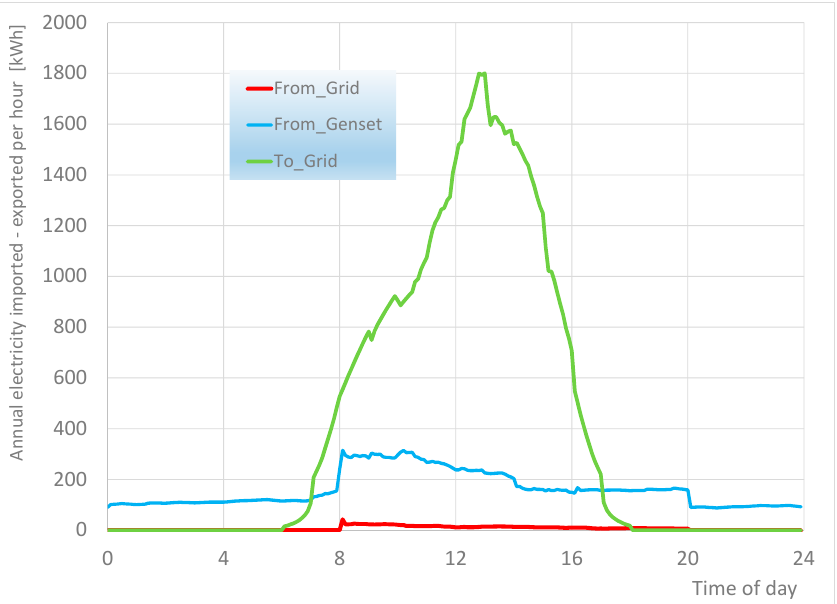
Figure 12. Power exported to grid (kW) as function of the day (horizontal axis) and the hour of day (vertical axis).